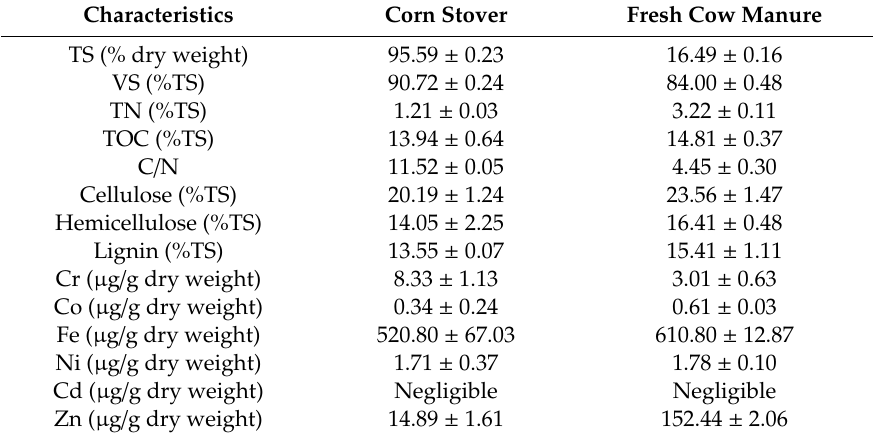
Table 1. Characteristics of corn stover and cow manure.